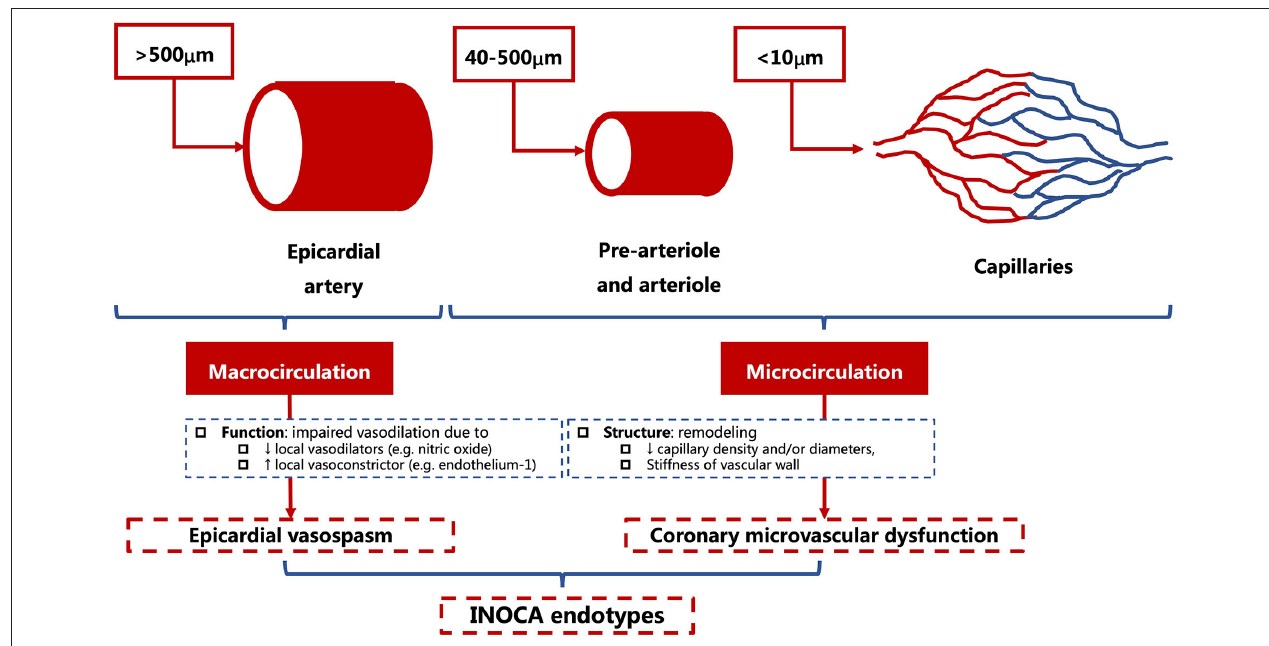
FIGURE 1 | Anatomical structures and pathophysiological endotypes of INOCA. INOCA, ischemia with non-obstructive coronary arteries.